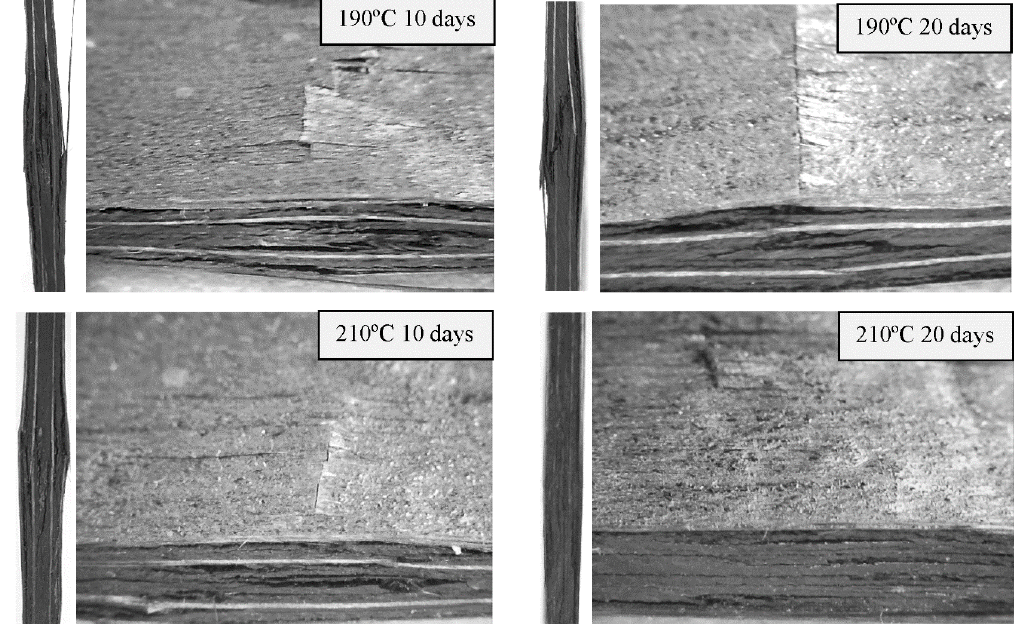
Figure 9 . CAI damage profiles during the CAI test of [0/90/±45] 2s quasi-isotropic laminates aged at Figure 9. CAI damage profiles during the CAI test of [0/90/ ± 45] 2s quasi-isotropic laminates aged at 190 °C and 210 °C for 10 and 20 days. An impact load of 20 J was applied on the front face. 190 ◦ C and 210 ◦ C for 10 and 20 days. An impact load of 20 J was applied on the front